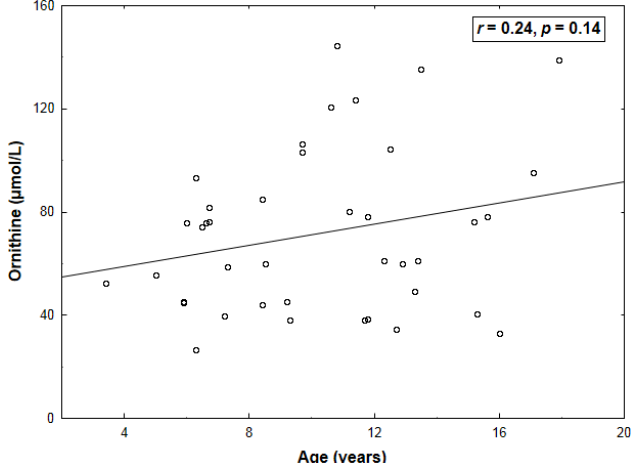
Figure 2. Lack of correlation between age and plasma ornithine